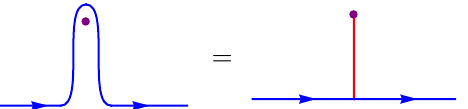
Figure 16 . Moving a TDL L (blue) past a bulk local operator leaves behind another (possibly non- simple) TDL (red) attached to a defect operator and a T-junction (with a speci(cid:12)ed junction